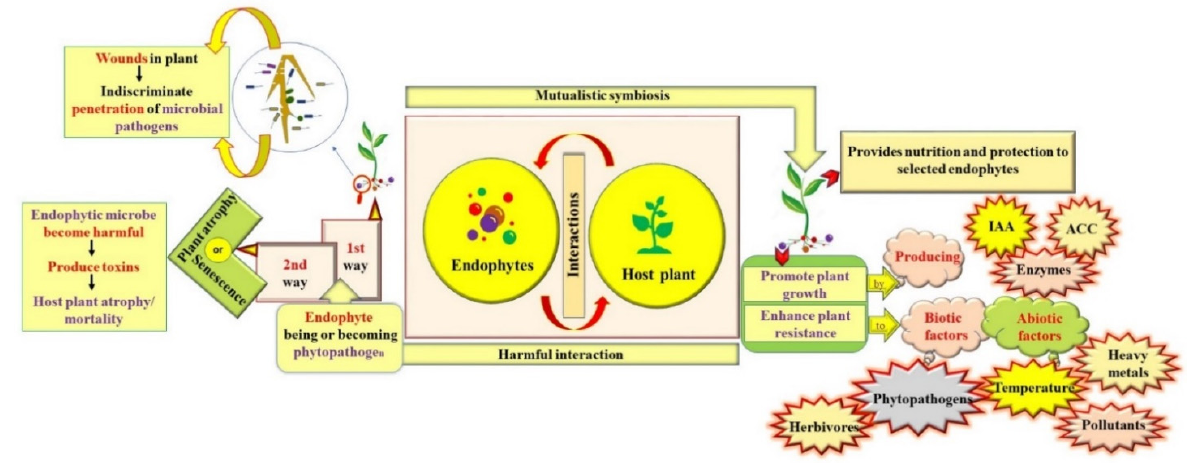
Figure 1. Interactions between fungal endophytes and host